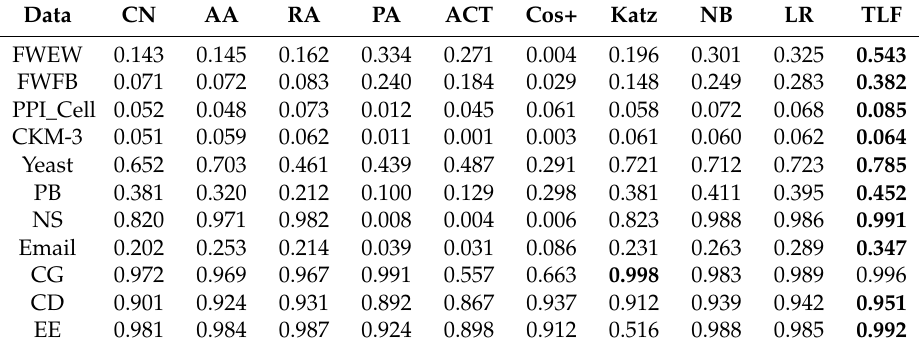
Table 7. Comparisons of the Precision value between TLF and other combination methods or global indices. In each network, the corresponding window width h is the same as Table 6. The bold figure indicates the best